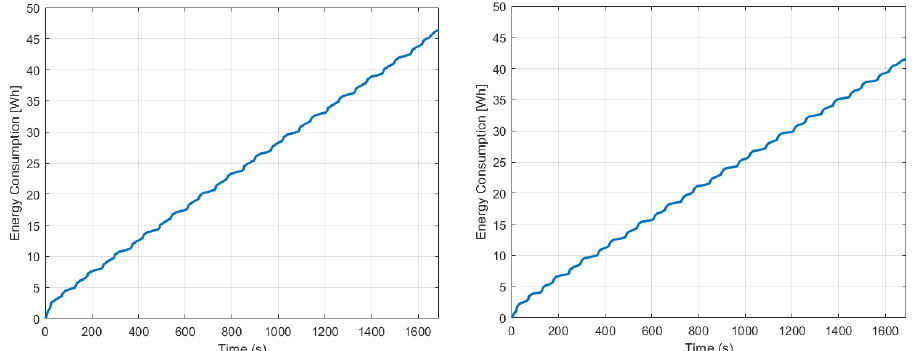
Figure 10. Energy consumption: geared friction wheel design with fixed ratio ( left ) and variable ratio CVT ( right